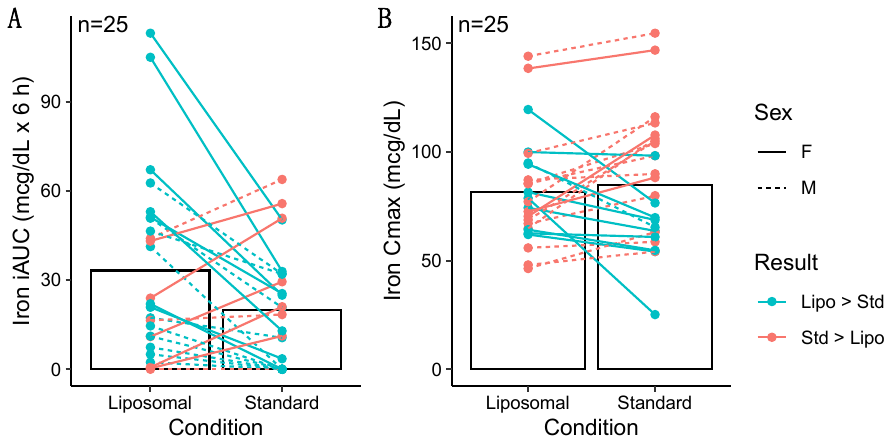
Figure 4. Individual differences in incremental area under the curve (iAUC; panel A ) and maximal observed concentration (Cmax; panel B ) values for iron. Iron iAUC values were significantly greater after ingestion of the liposomal product as compared to the standard product ( p = 0.016 via paired samples t -test), with no difference observed for Cmax ( p = 0.51 via paired samples t -test). Individual responses are represented by lines, and bars represent mean values in each condition. Table 4. Incremental area under the concentration vs. time curve (iAUC) comparison.